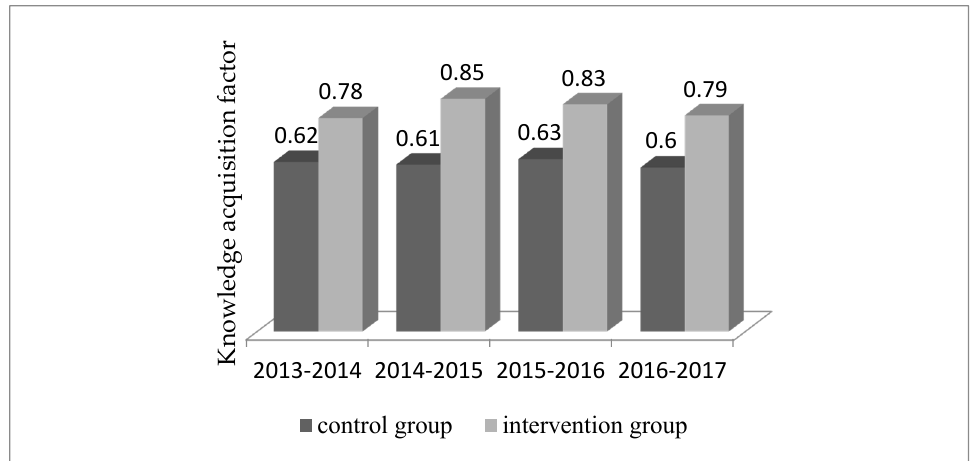
Figure 6. Diagram of dynamics of knowledge acquisition factor for control and intervention groups for the first year of studies.